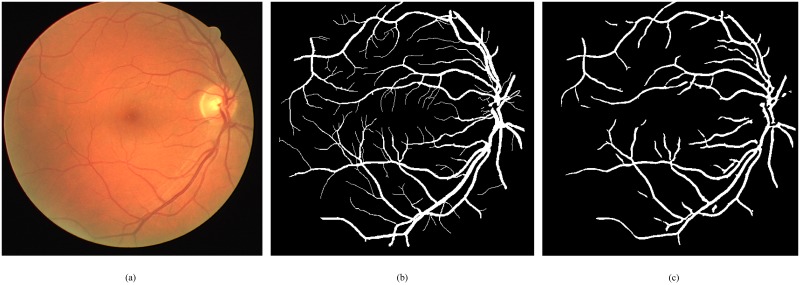
Visual appearance of the proposed technique utilizing DRIVE dataset.(a) RGB photograph (b) Manual segmentation (c) Proposed technique segmented image.